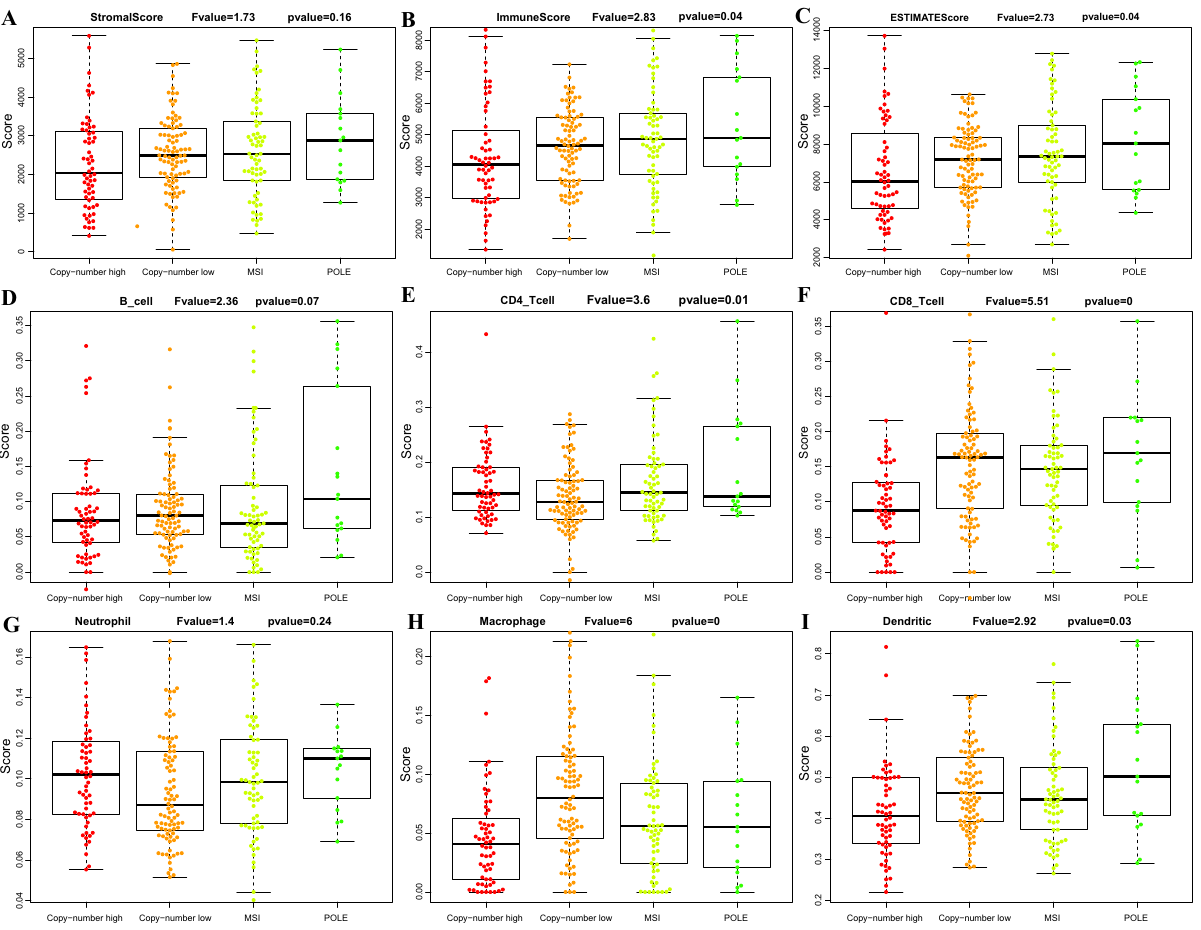
Figure 2. Distribution of StromalScore ( A ), ImmuneScore ( B ), ESTIMATEScore ( C ) and B cell ( D ), CD4 + T cell ( E ), CD8 + T cell ( F ), Neutrophil ( G ), Macrophage ( H ), Dendritic cell ( I ) infiltration among 4 different molecular subtypes (Copy − number high, Copy − number low, MSI and